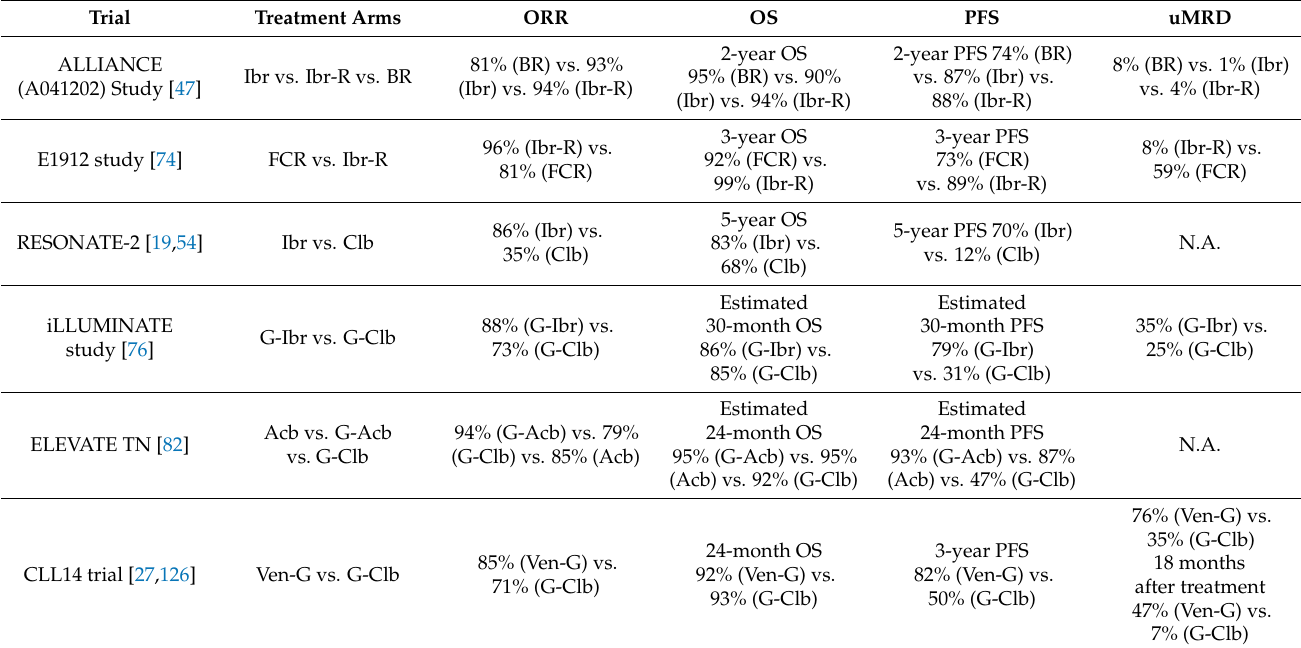
Table 1. Overview of phase 3 trials in tn